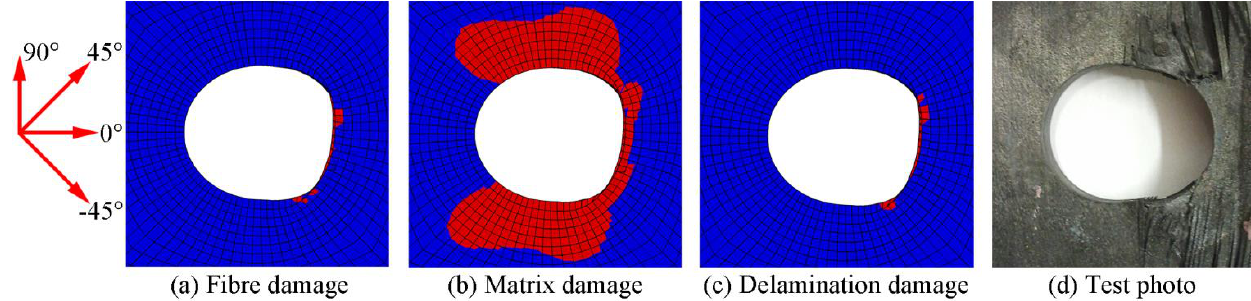
Figure 17. Deformation and damage distribution at the specimen in the final failure state with the fibre orientation